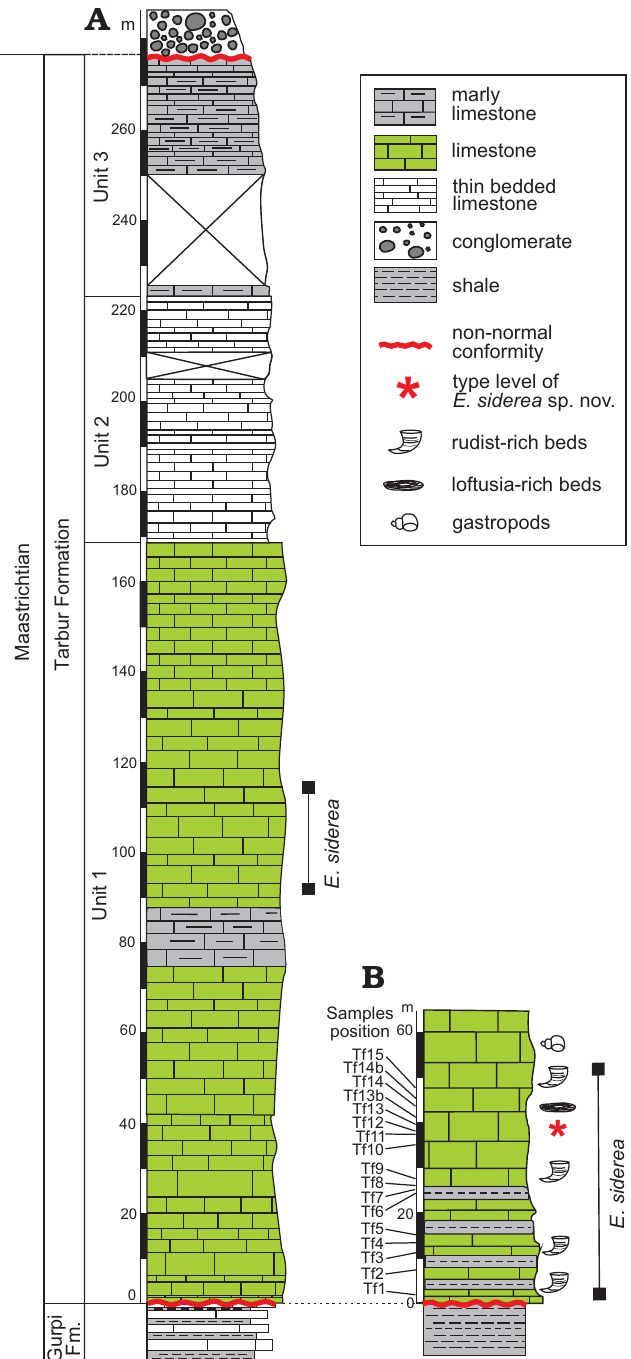
Fig. 3. Stratigraphic columns from Mandegan ( A ) and Rod-Abad ( B ) sec- tions with position of the studied samples and distribution of Elazigina siderea sp.